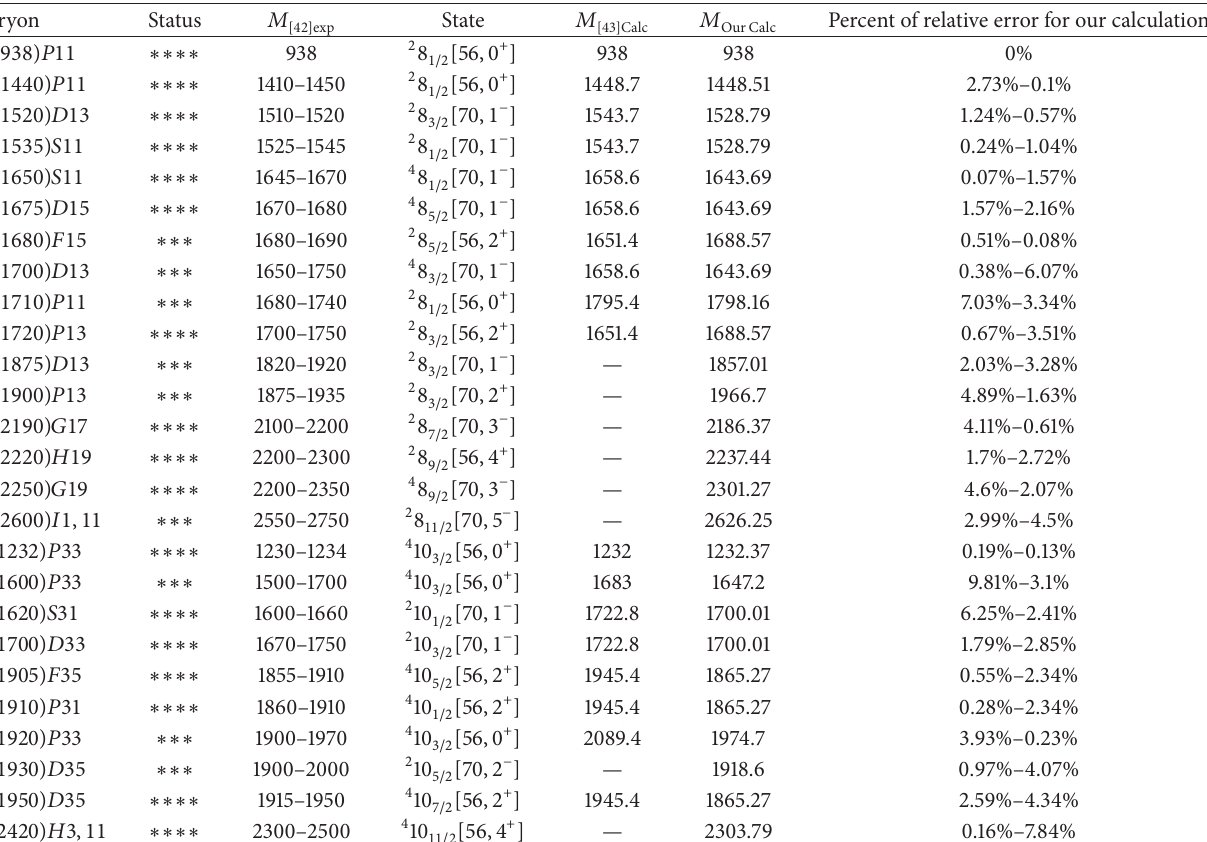
Table3:Massspectrumofbaryonsresonances(inMeV)calculatedwiththemassformula(22).Thecolumn 𝑀 OurCalc containsourcalculations shows calculations of Giannini et al. Column 7 indicates the percentage of relative error with the parameters of Table 2 and column 𝑀 [43]Calc for our